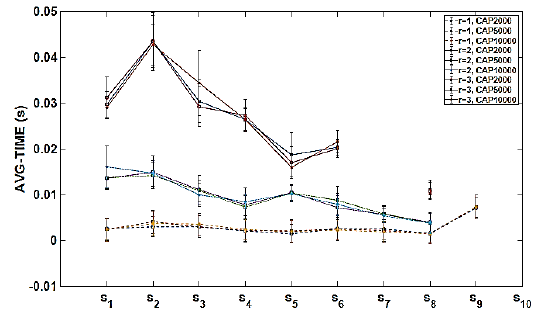
Figure 4. Average execution time of the proposed algorithm for the Sprint topology.